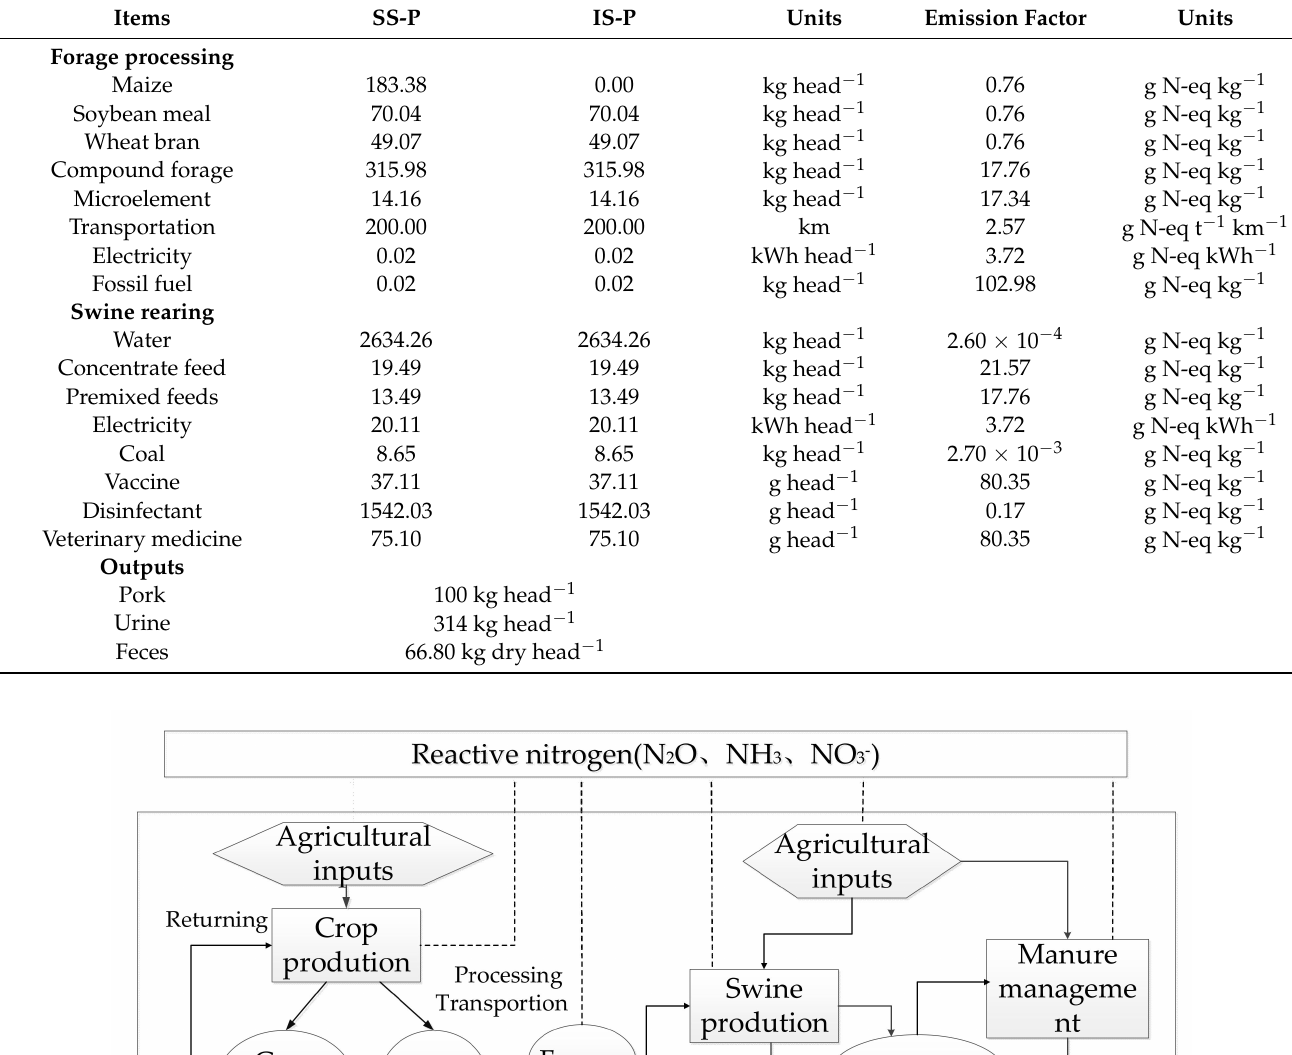
Table 2. Inputs and outputs for swine production, SS-P is the pig production system of separated system and IS-P is the pig production subsystem of integrated system.